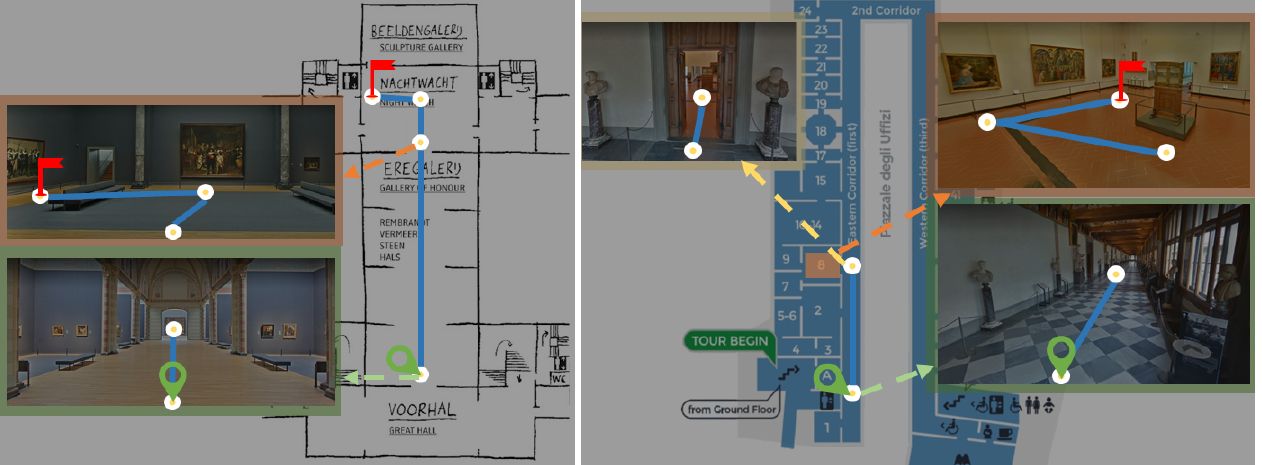
Figure 8. Low level navigation task, the Rijksmuseum on the left , the Uffizi Museum on the right . The layout maps are from https://www.visituffizi.org/museum/uffizi-floor-plans/ and https:// kalden.home.xs4all.nl/mann/Mannheimer-inrijksmuseum.html (accessed on 20 November 2022) See text for